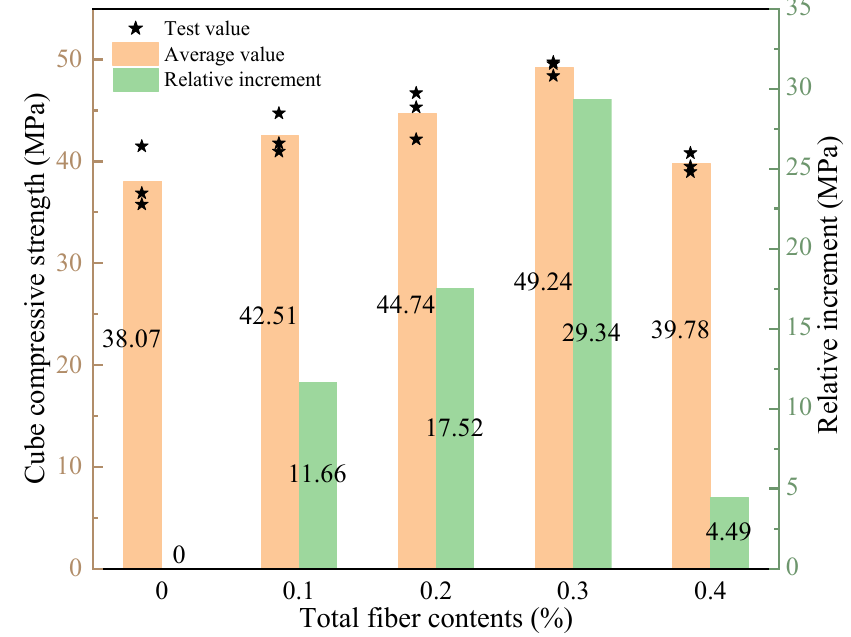
Figure 5. Compressive strength of LHPCC with different total fiber content.